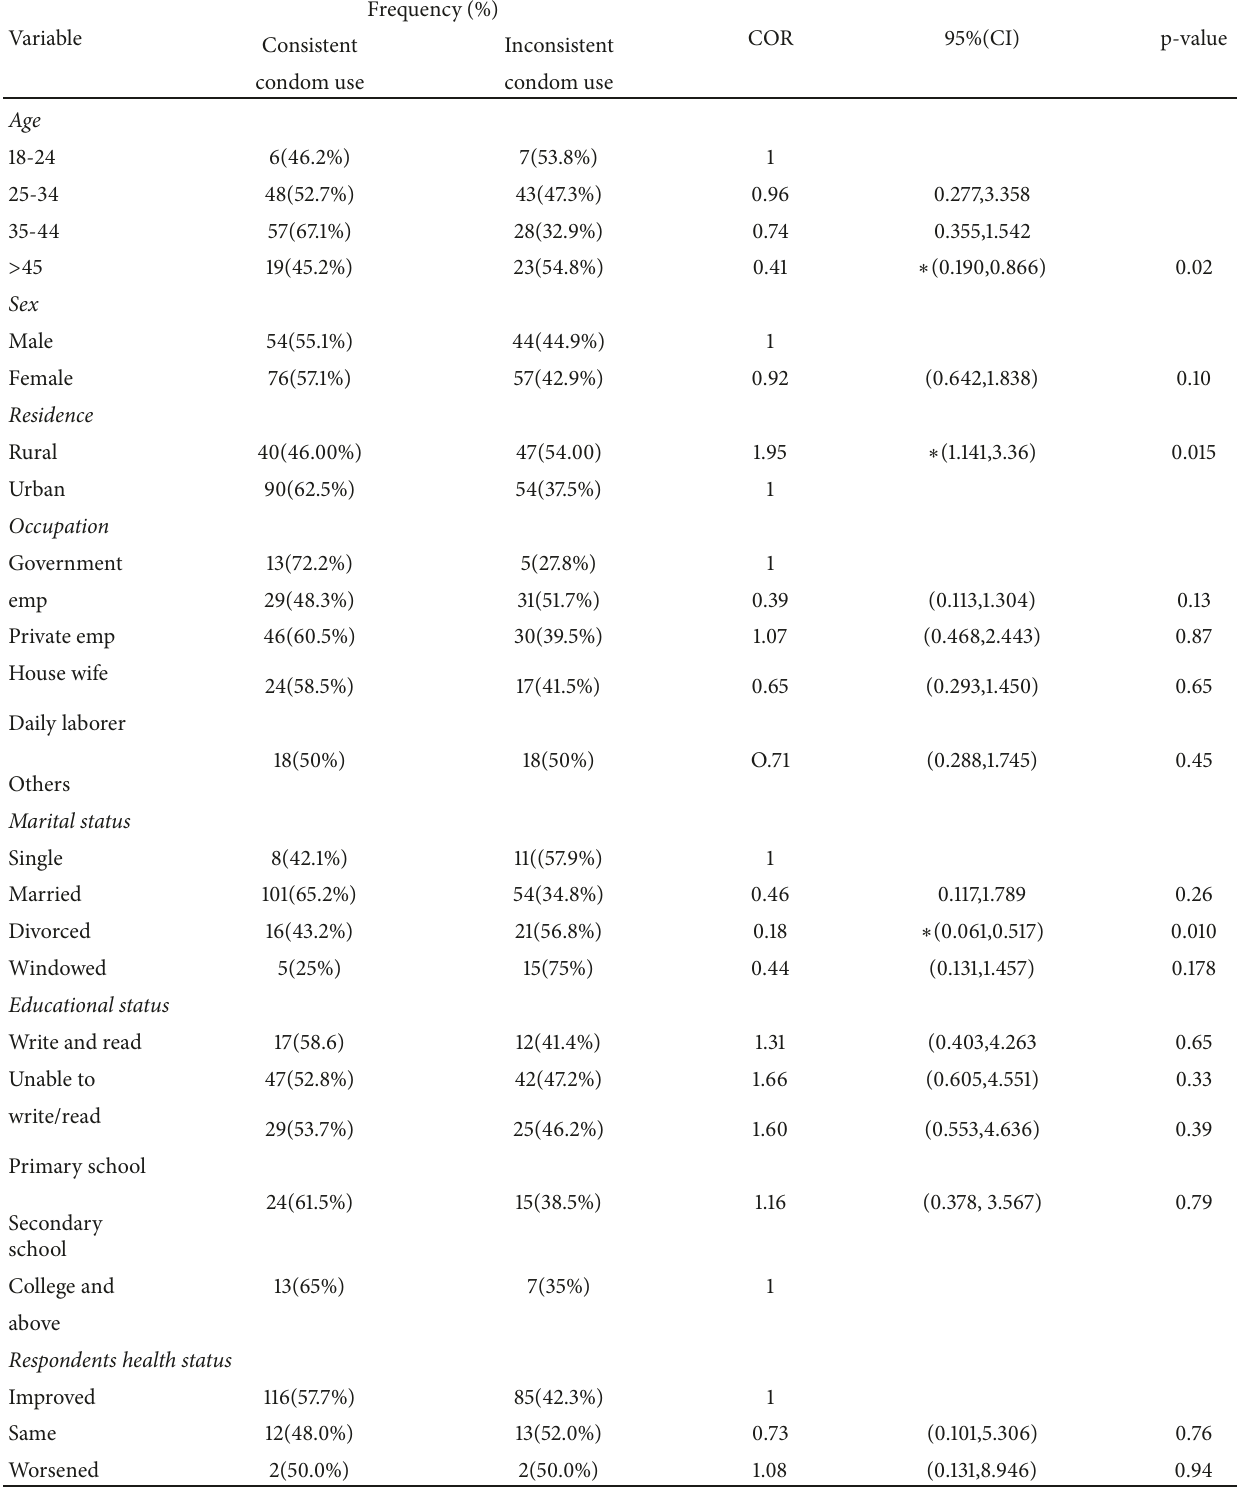
Table 4: Bivariate analysis by socio-demographic factors with consistent condom of the respondents in Kollidiba health center, North West Ethiopia,